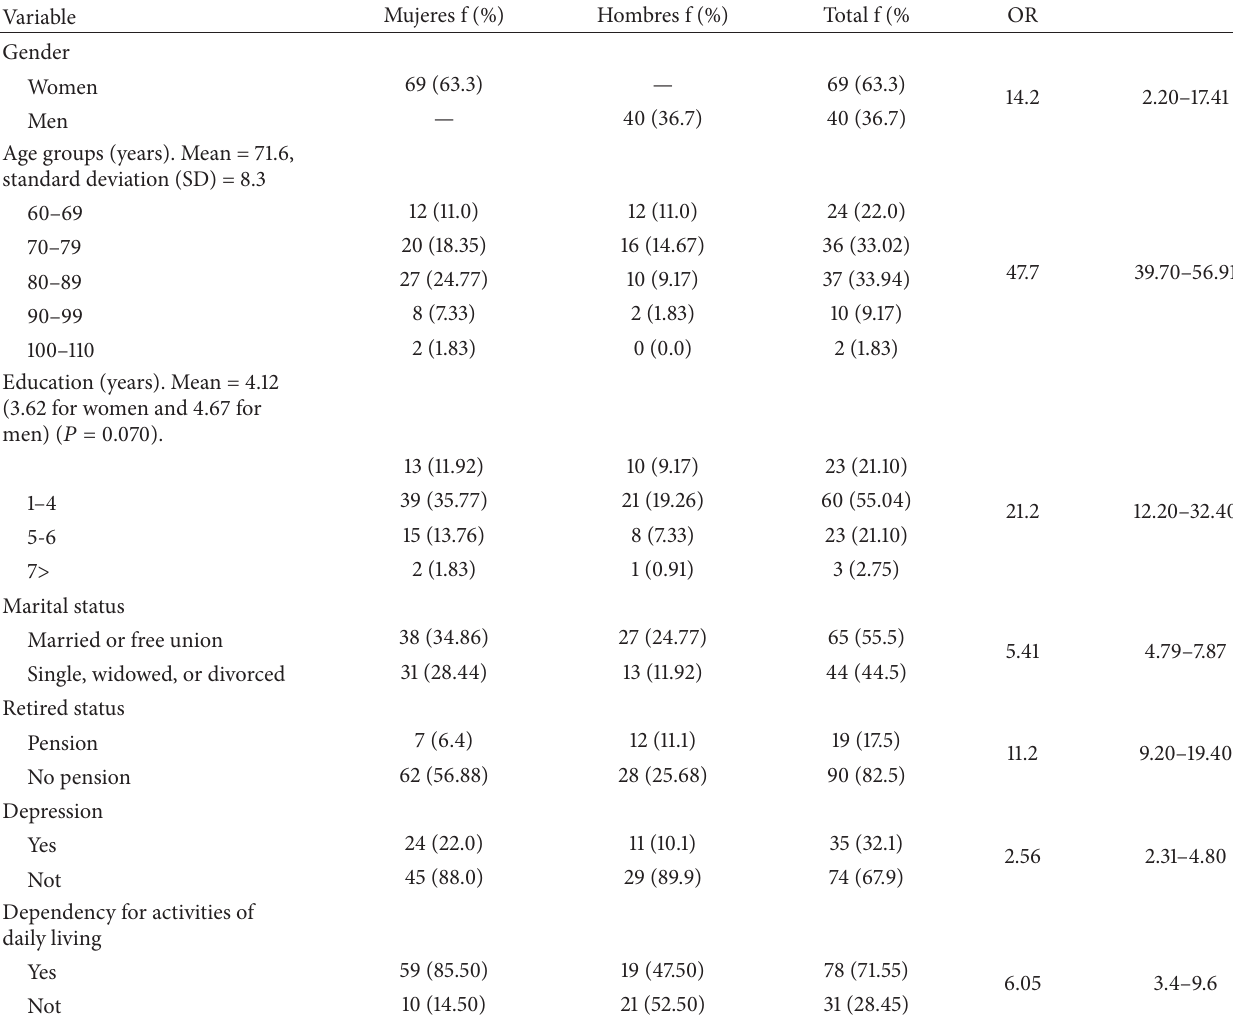
Table 2: Association between sociodemographic characteristics and mental and physical status ( 𝑛 = 109 older adults with dementia). Variable Mujeres f (%) Hombres f (%) OR Gender Women Age groups (years). Mean = 71.6, standard deviation (SD) =